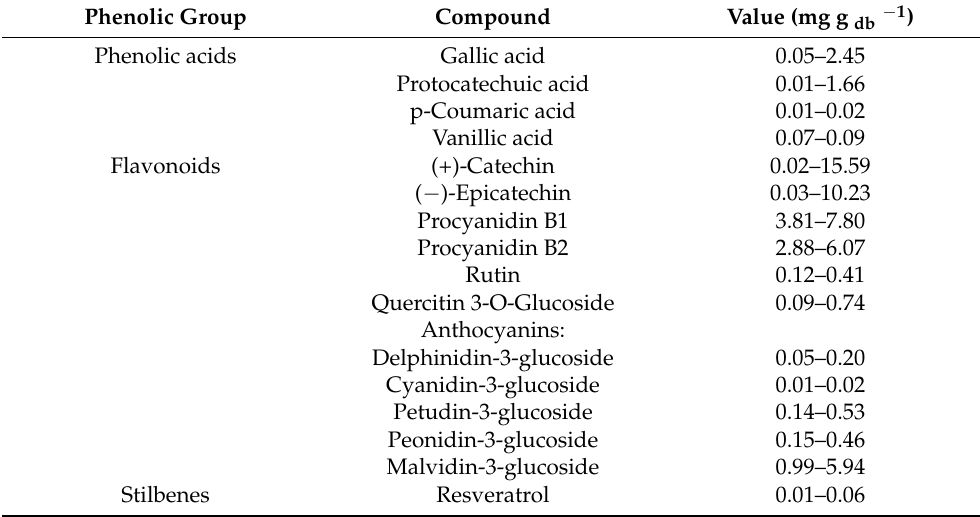
Table 13. Phenolic compounds in the extracts from winery